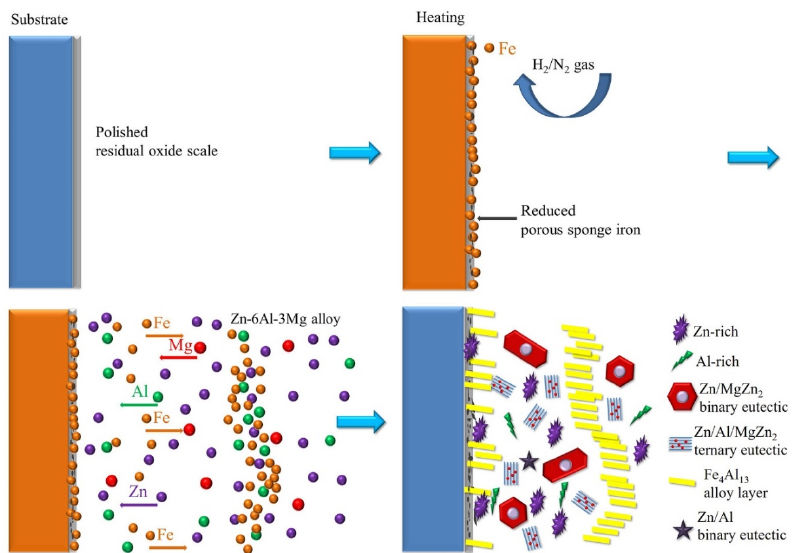
Figure 14. Diagram of coating formation of polished steel plate.